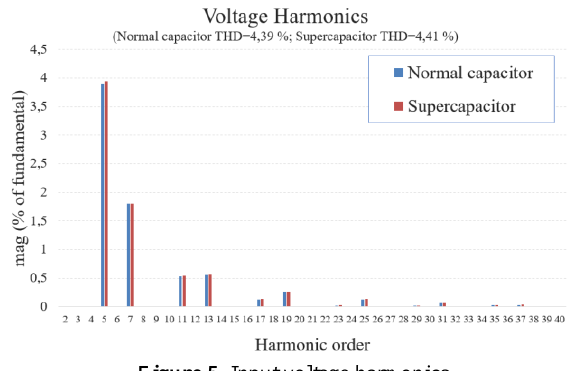
Figure 5. Input voltage